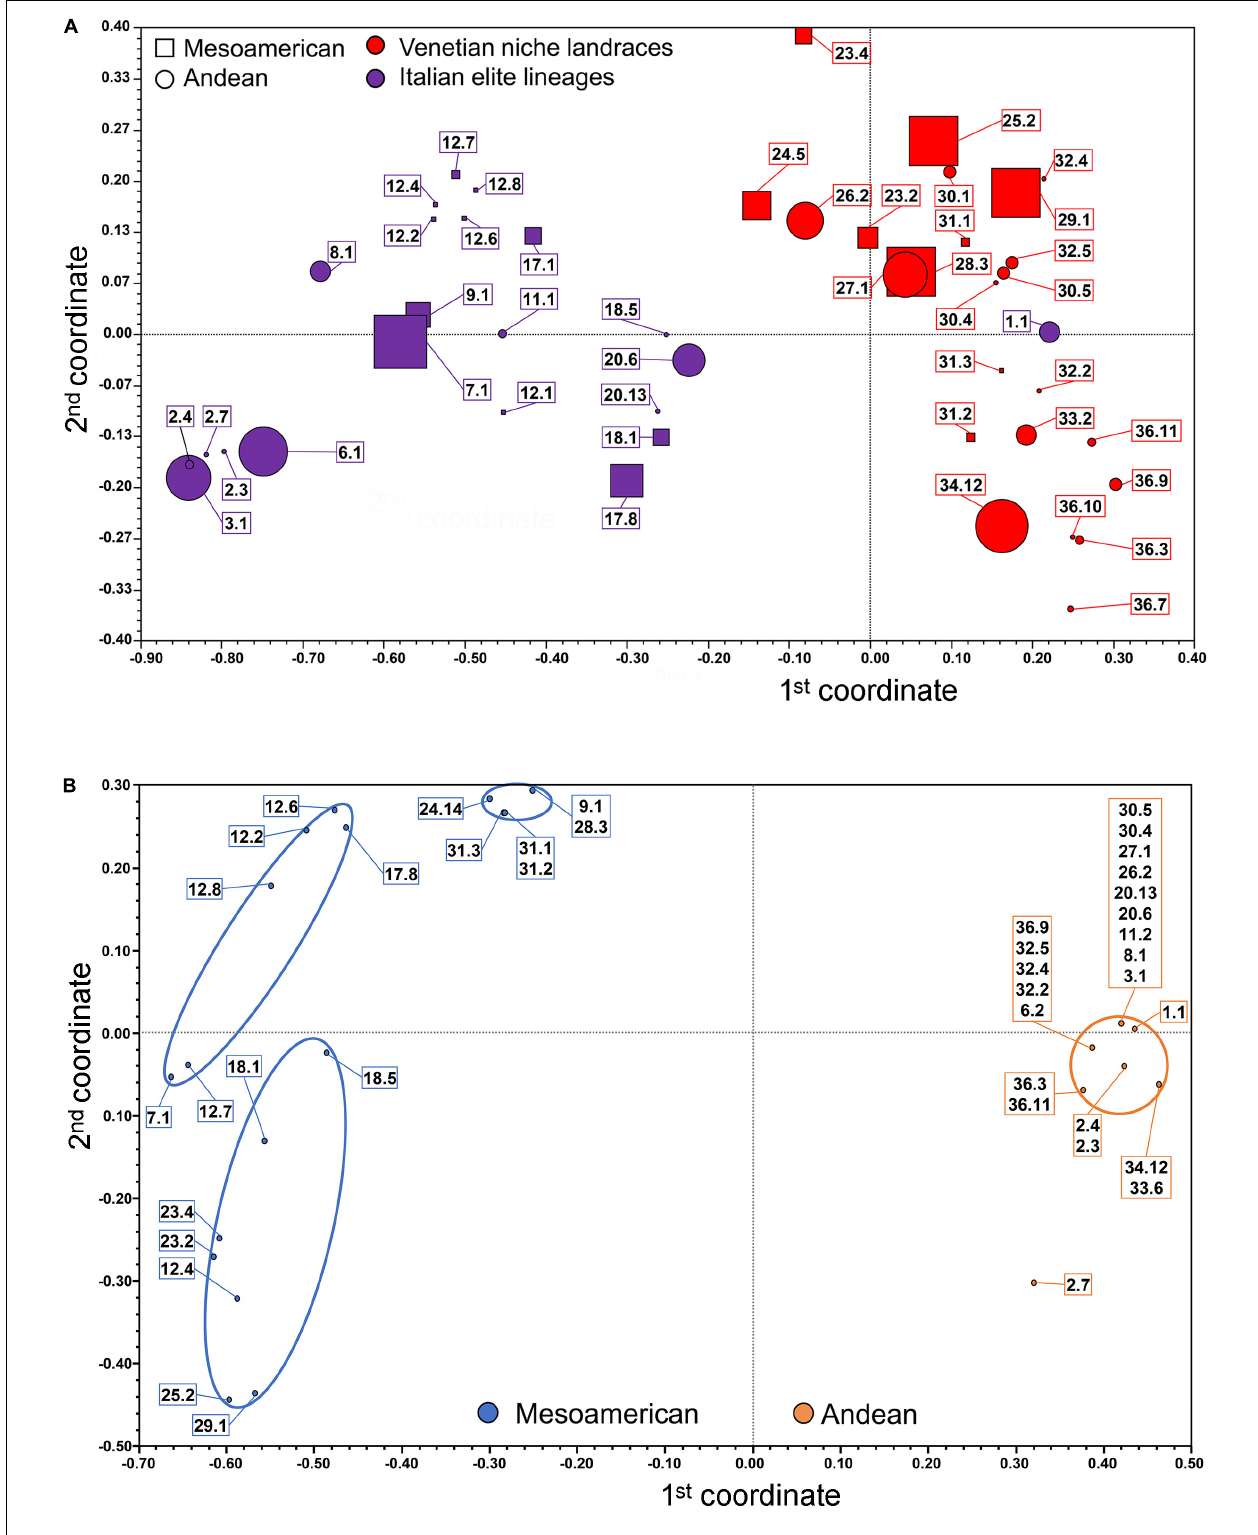
FIGURE 1 | Principal Coordinate Analysis of the common bean accessions based on SSR and SNP markers: (A) Bidimensional centroids of the total 193 analyzed samples (symbol size is proportional to the number of samples scoring full genetic identity). (B) Bidimensional clusters of the 41 common bean unique genotype accessions identified through SSR markers and analyzed using SNP markers for the eleven chosen genes.